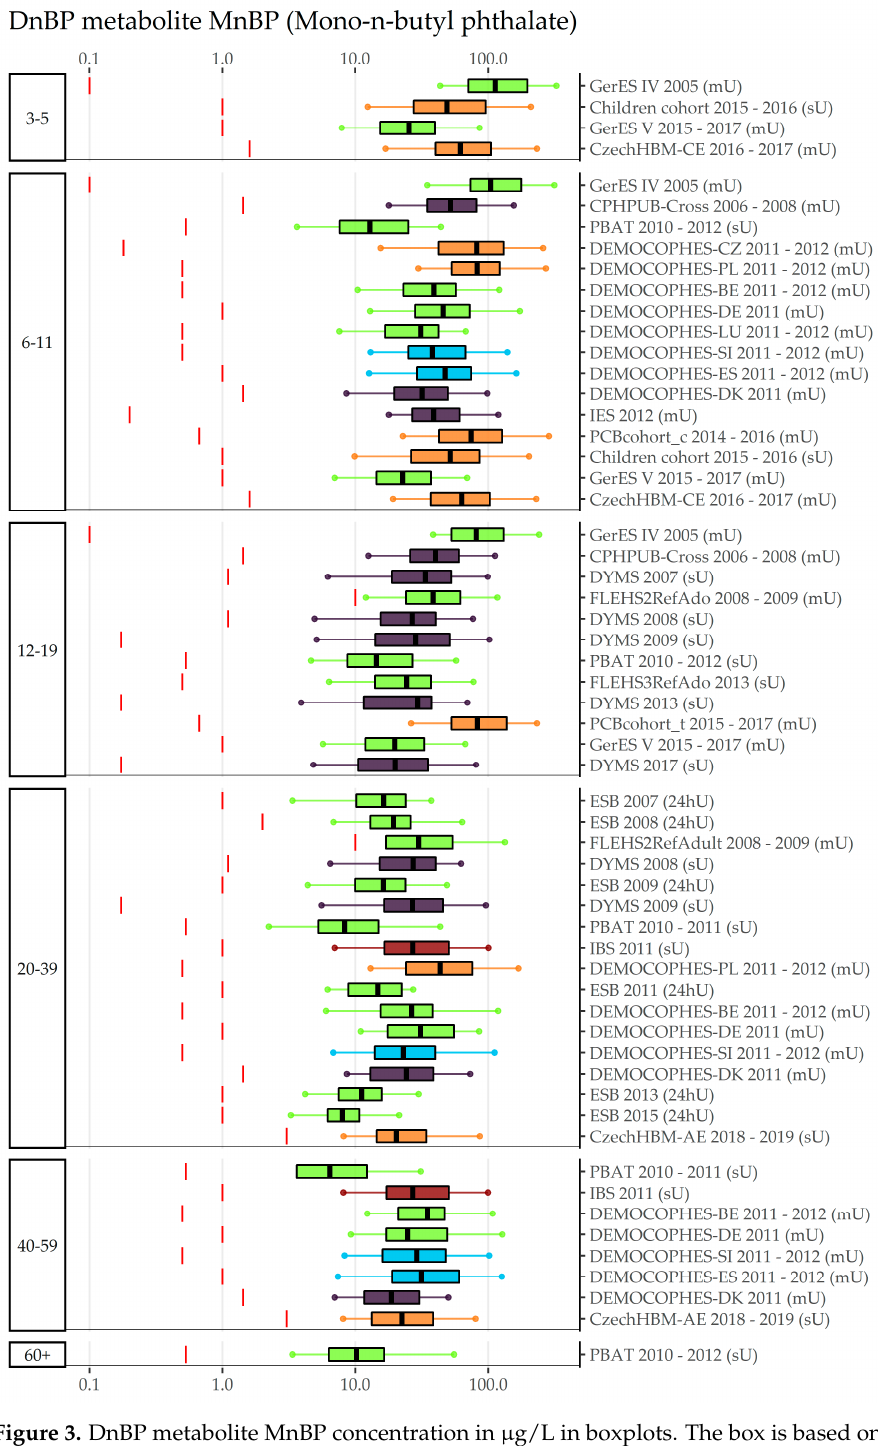
Figure 3. DnBP metabolite MnBP concentration in µ g/L in boxplots. The box is based on P25, P50, 3 and P75, and the whiskers are based on P5 and P95. Boxplots are presented separately by age groups; within age groups they are chronologically sorted by year of sampling. Colors of the boxplots refer to the data collection’s region (North = violet, South = blue, West = green, East = orange, Israel = dark red). Red lines denote LOQ/LOD for the respective study. Since percentiles are only available and displayed when they are above LOQ/LOD, the lower side of boxplots might be